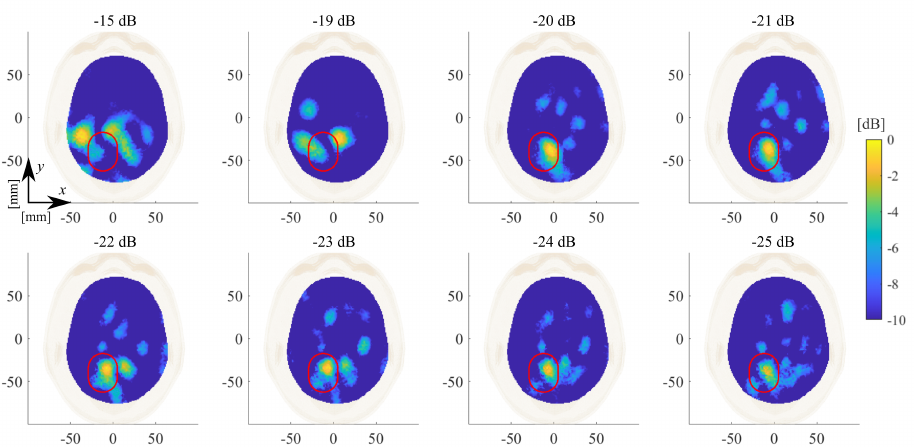
Figure 8. ICH-HP_I amplitude values of the normalized reconstructed dielectric contrast in the transverse plane view varying the threshold on the singular values between − 15 and − 25dB. The expected stroke area is indicated with a red line.